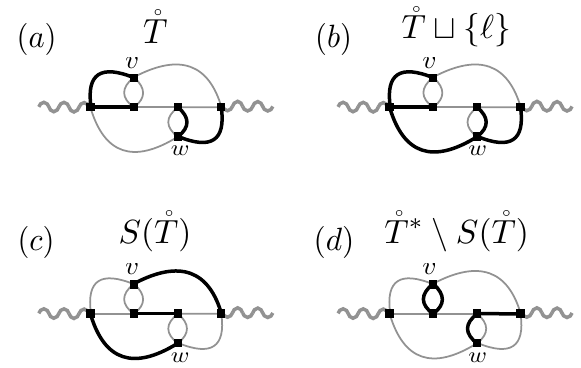
Figure 6 . Examples of sets entering the de(cid:12)nition of a 2-tree. Figure (a) shows an example 2-tree (cid:23) T , and (b) illustrates the de(cid:12)ning property, that at least one line ‘ exists in the complement,